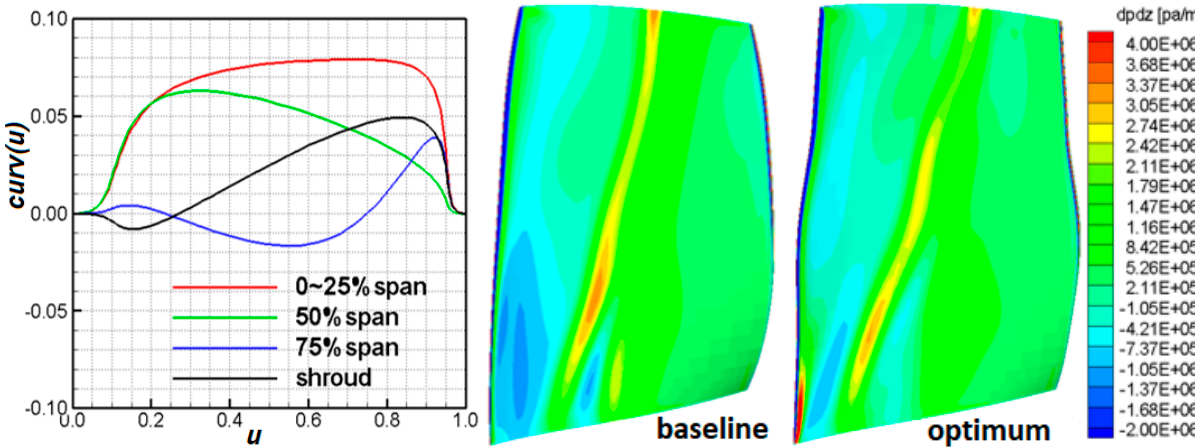
Figure 19. Optimum chordwise curvature definition at various spans (shroud = 100% span) and pressure gradients on the baseline and optimum, showing improved attached flow (top 15% span).